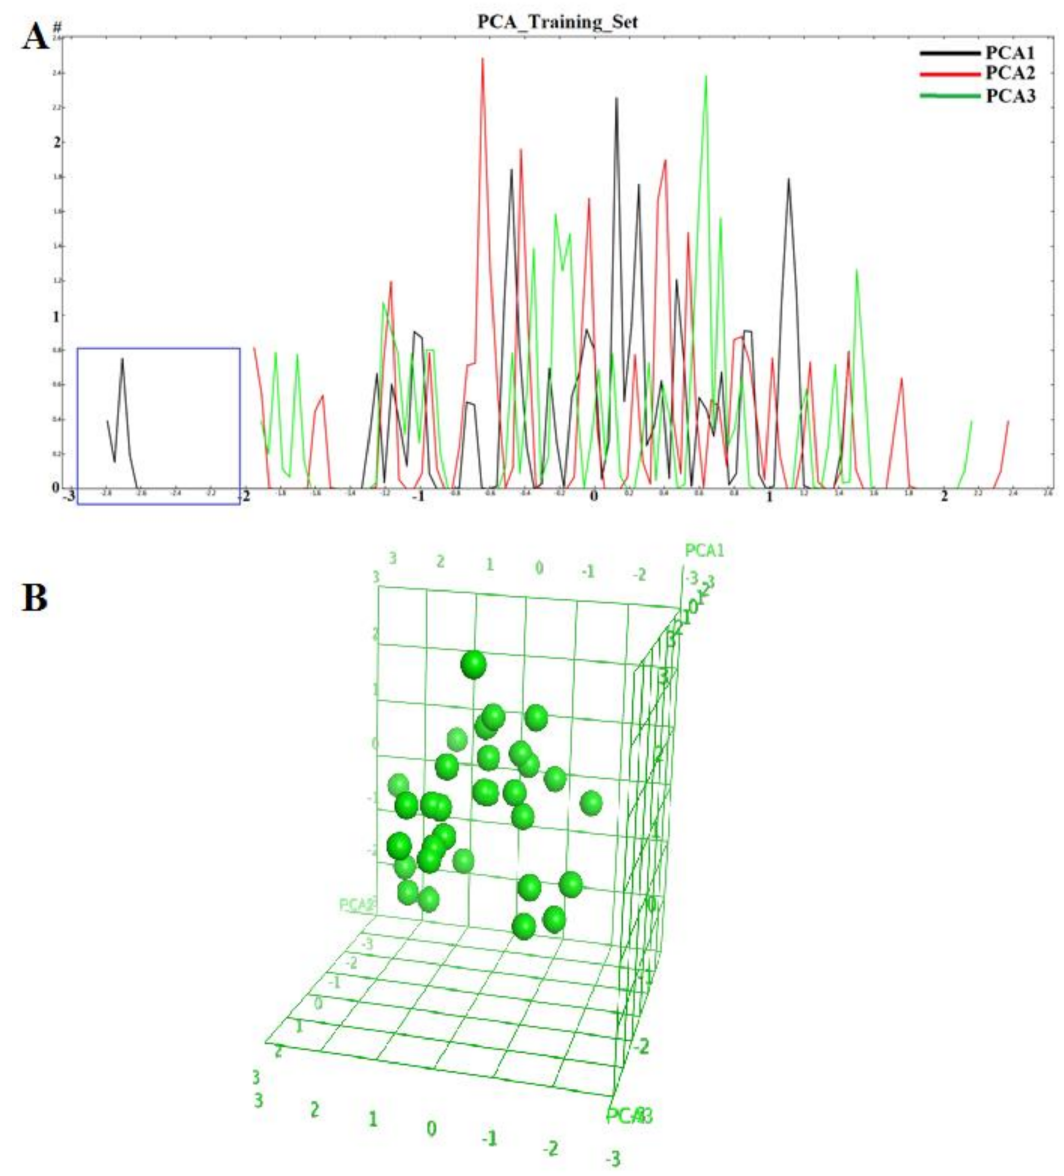
Figure 2. ( A ) 2D plots to visualize the variation of the three most important computed principal components for the training set (Blue box represent the outlier TH58) and ( B ) 3D visualization of the chemical space occupied by the training set molecules using the first three